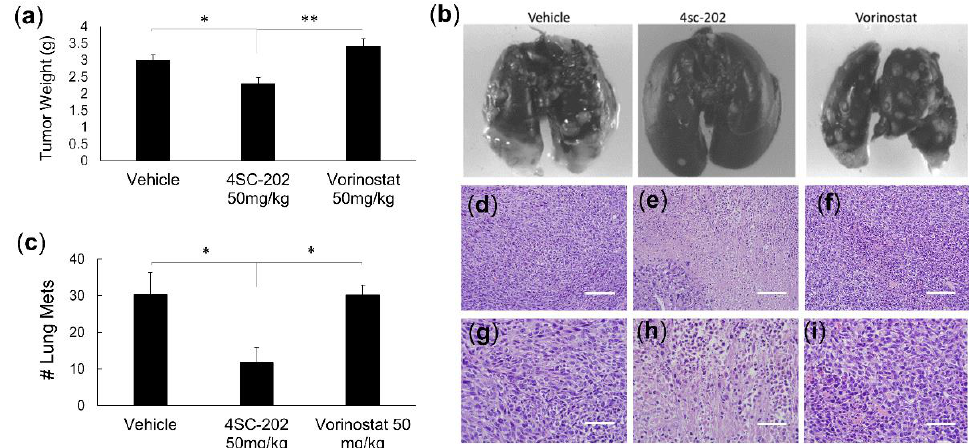
Figure 5. 4SC-202 significantly reduces both tumor weight and lung metastasis. ( a ) 4SC-202 (50 mg/kg) significantly reduces tumor weight after 2 weeks of treatment compared to Vorinostat (50 mg/kg) and the vehicle control treatment (ANOVA p = 0.005). ( b ) Fewer metastatic nodules in the lungs are visible in 4SC-202 treated mice as compared to Vorinostat- and vehicle-treated mice. ( c ) Quantification of lung metastases indicates 4SC-202 significantly reduces the number of lung metastases as compared to Vorinostat and the vehicle treatment (ANOVA p = 0.02). For A and C, hypothesis testing was conducted using single factor ANOVA with a post-hoc Tukey’s test. Significance between groups is indicated p < 0.05 (*), p < 0.01 (**). ( d – i ) H&E staining of tumor sections from mice treated with 4SC-202 ( e , h ) , Vorinostat ( f , i ) or vehicle control ( d , g ) indicates 4SC-202 induces marked dissolution of chromatin or karyolysis ( e , h ). All data were collected from mice in Experiment 2. Images are representative of 12 tumors analyzed by H&E. Magnification in ( d – f ) is 100× with scale bar = 25 microns., and in ( g – I ) is 200× with scale bar = 50 microns.